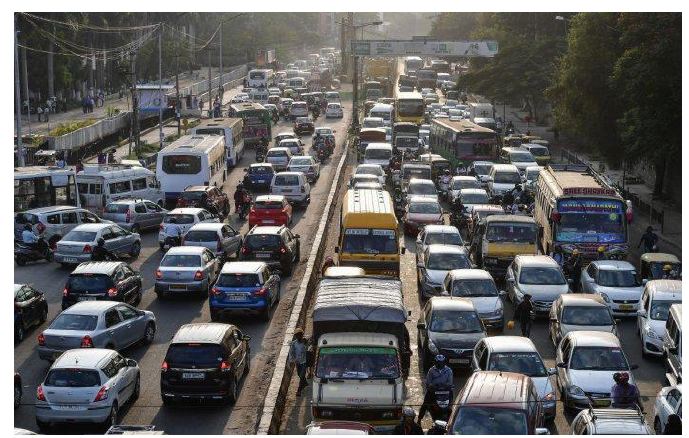
Figure 16. Before detection [63].